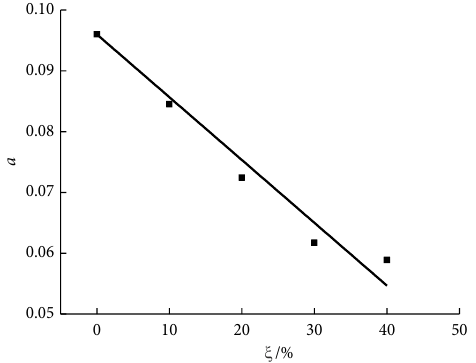
Figure 11. Relationship between the rubber substitution rate and parameter a